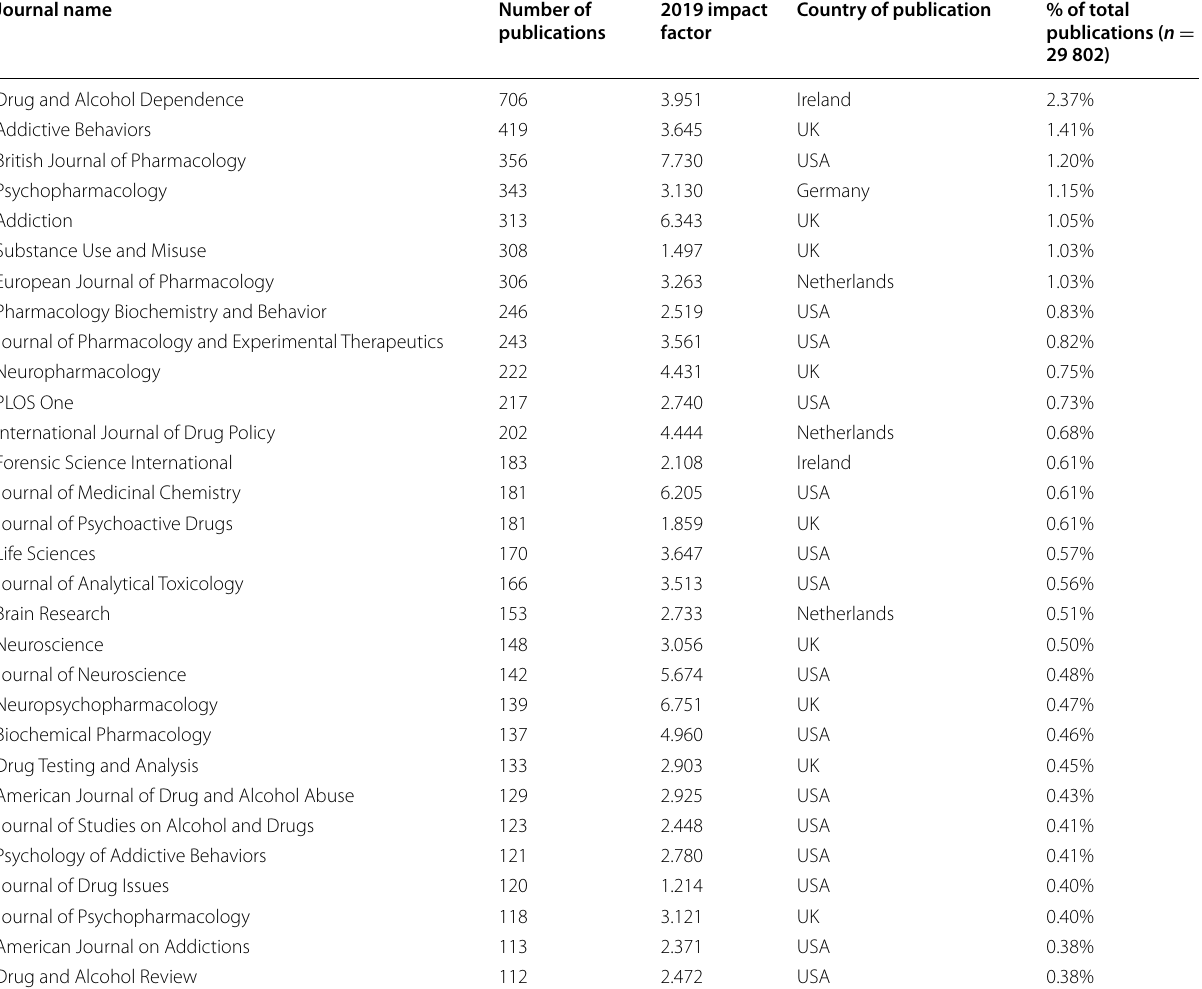
Table 1 Characteristics of the 30 journals having published the highest number of cannabis and cannabinoid publications